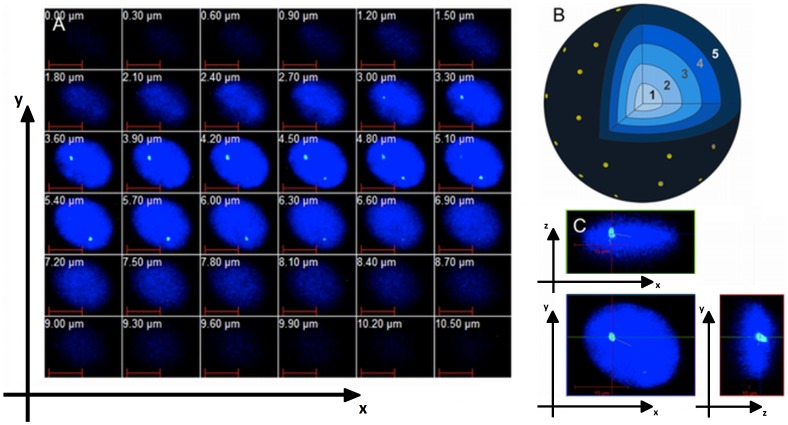
Scheme of 3D analysis of interphase nuclei.A – stack of pictures collected in the Z-axis; B – model of 3D reconstruction of the nucleus with a schematic view of the co-centric shells; C – evaluation of centromere position in the 3D nucleus environment.